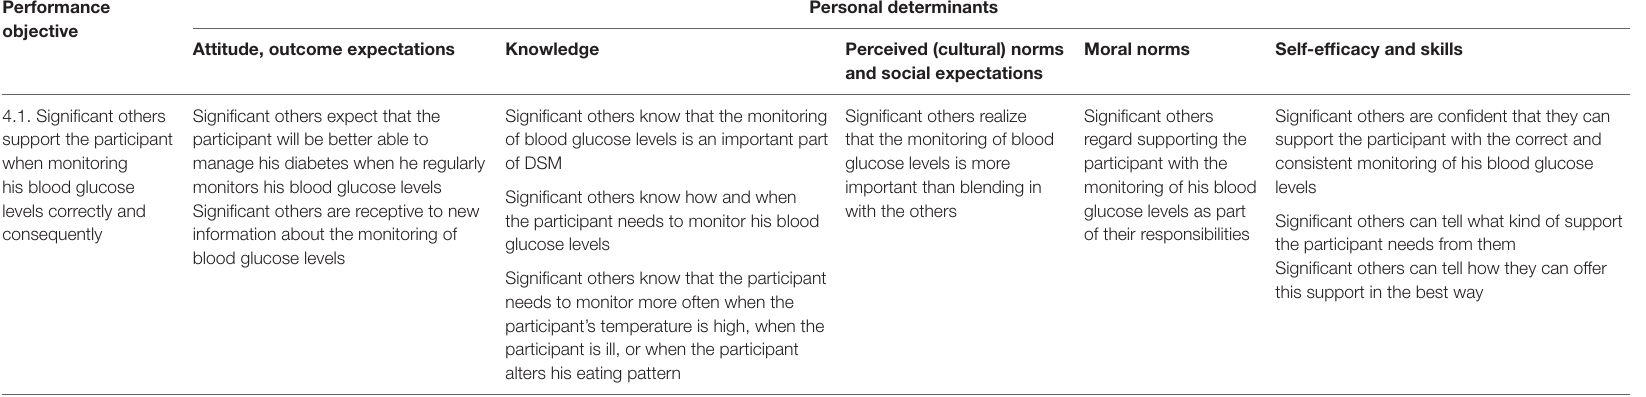
TaBle 10 | Example of change objectives—the significant others.